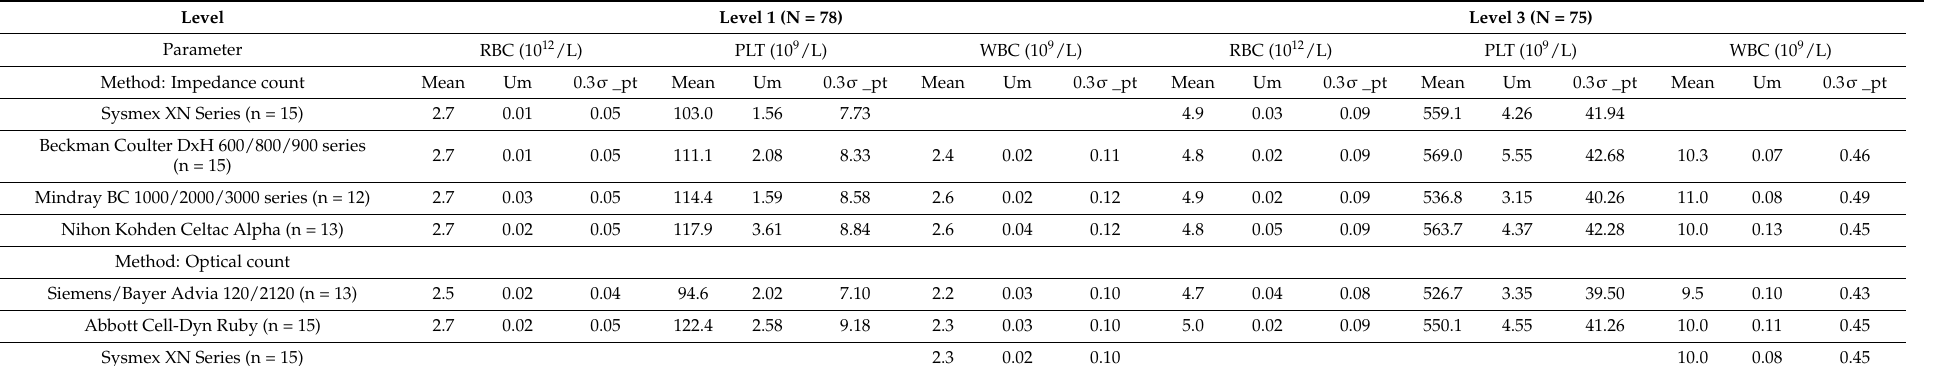
Table 3. Evaluation blood cells of CBC EQA material by instrument groups.